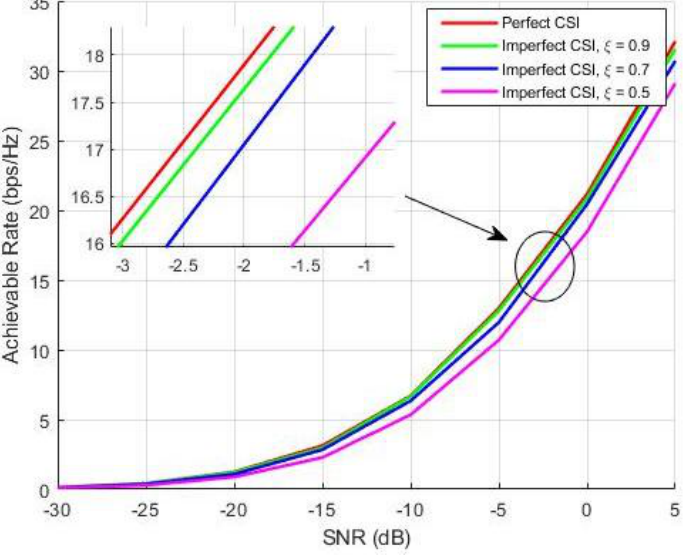
Figure 12. Perfect channel state information (CSI) vs Imperfect